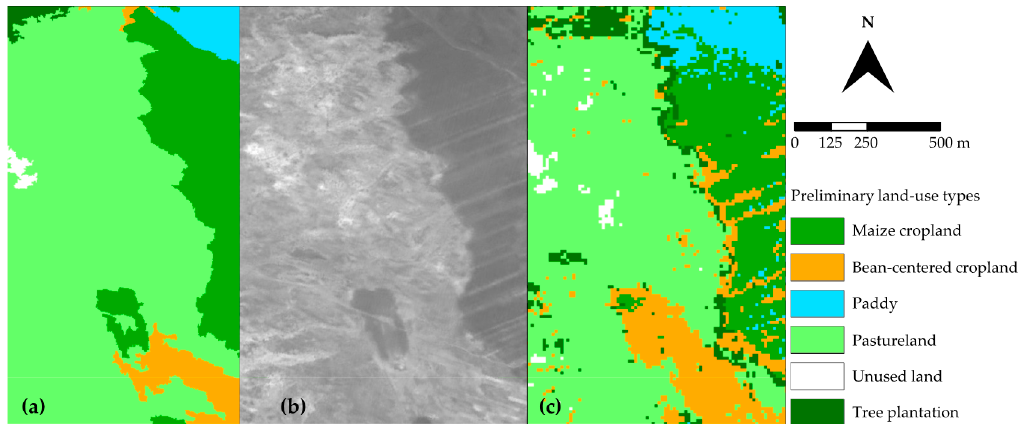
Figure 1. Subset images of ( a ) the object-based classification result, ( b ) the summer Panchromatic Remote-sensing Instrument for Stereo Mapping (PRISM) data, and ( c ) the pixel-based classification result.